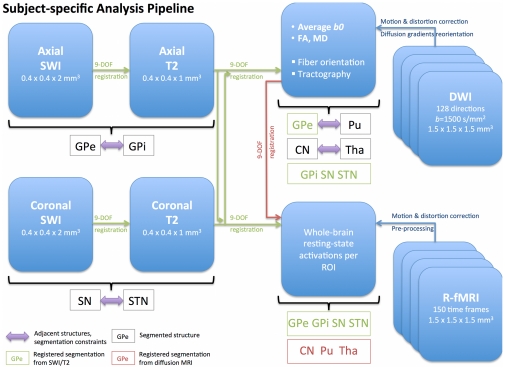
Subject-specific analysis pipeline.This diagram summarizes the pre-processing, registration, and segmentation steps that were required to identify the seven regions-of-interest used in this work: caudate nucleus (CN), putamen (Pu), external and internal globus pallidus (GPe and GPi), substantia nigra (SN), subthalamic nucleus (STN), and thalamus (Tha). Axial SWI and T2-weighted images were linearly registered using nine degrees-of-freedom (DOF), and used to delineate GPe and GPi. Coronal SWI and T2-weighted images were also linearly registered using nine DOF, and used to delineate SN and STN. The purple arrows indicate spatial relations between structures, exploited to segment them (i.e. GPe and GPi are adjacent and simultaneously segmented). Diffusion-weighted images were corrected for motion, eddy-current, and susceptibility-induced distortions, and were then used to estimate fractional anisotropy (FA) and averaged b0 images. Subsequently, axial and coronal high-resolution T2-weighted images were aligned with the averaged b0 in order to resample segmentations of GPe, GPi, SN, and STN into diffusion native space, and then used for tractography seeding. CN, Pu and Tha were segmented from the FA image. Finally, resting-state fMRI (R-fMRI) data were corrected for motion and susceptibility-induced distortions. An average R-fMRI image was created and used as a template to register axial and coronal T2-weighted images, and b0, in order to resample all regions-of-interest into R-fMRI native space and then to generate R-fMRI activation maps.